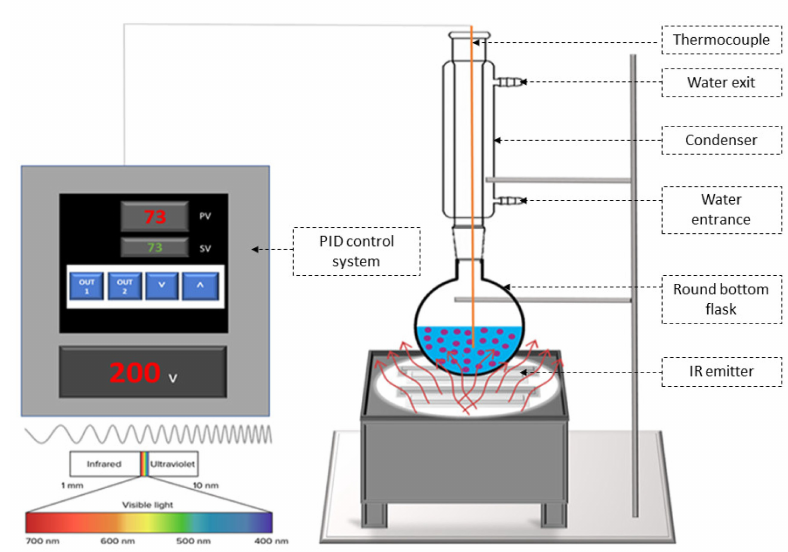
Figure 1. Infrared radiation instrument